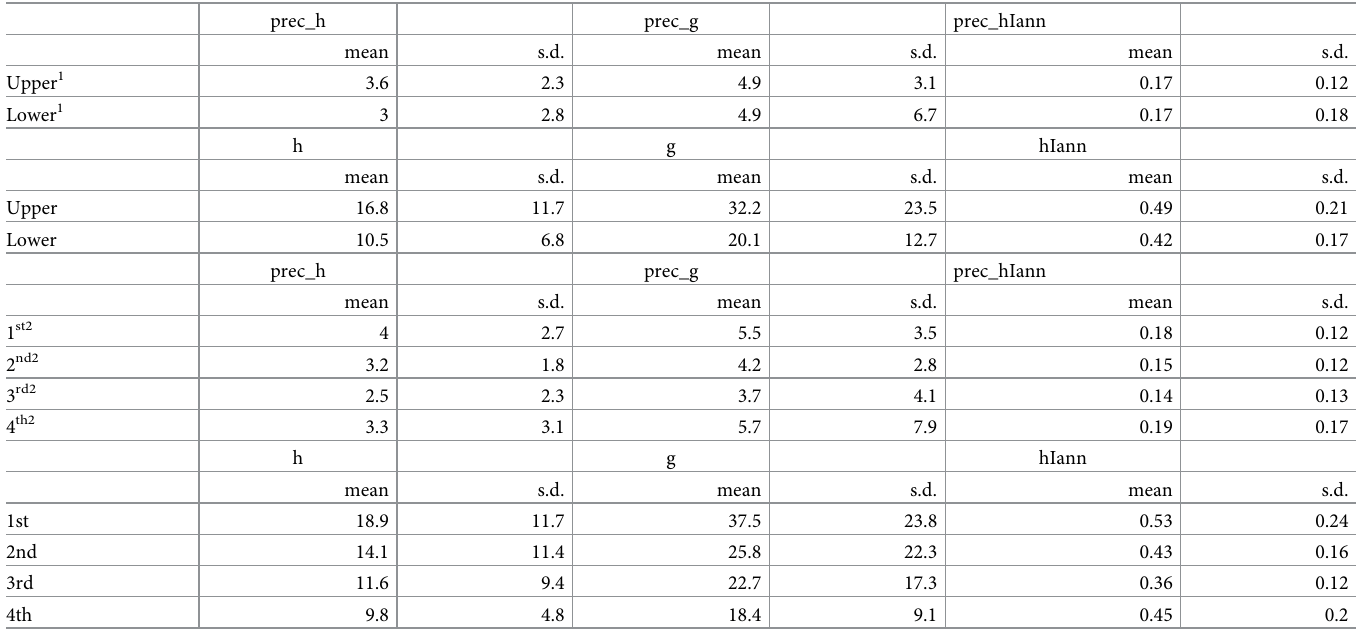
Table 5. Precocity and career measures (mean, standard deviation [s.d.]) by NRC rank upper and lower halves, and descending